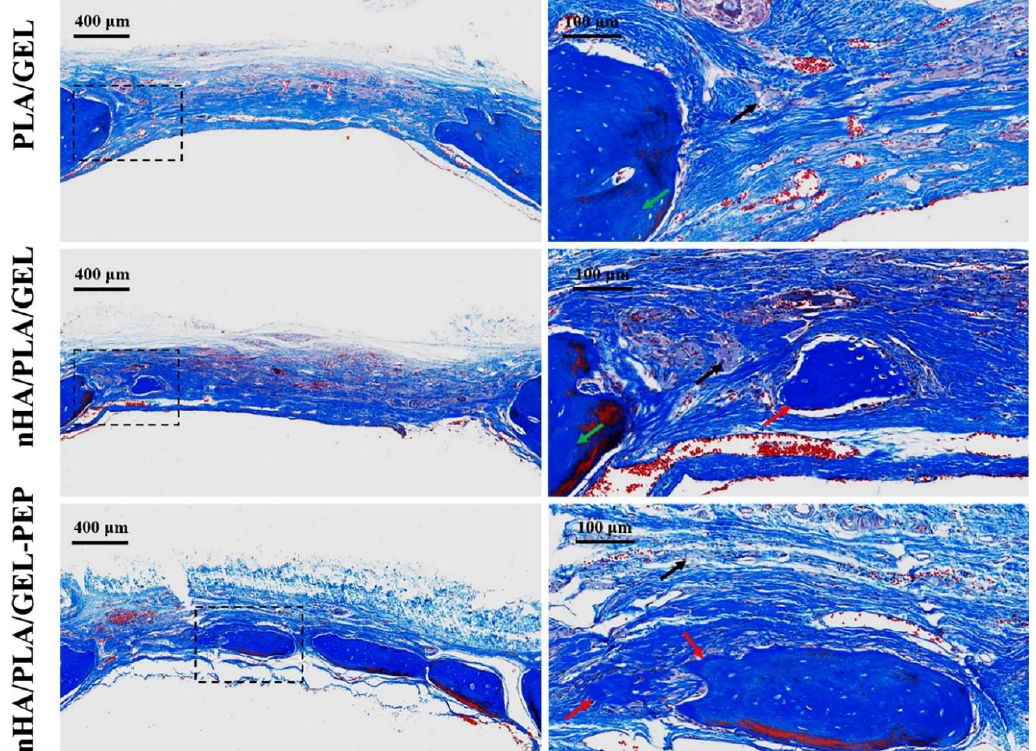
Figure 4. Masson’s trichrome-stained images of the newly formed bone within the repaired tissue eight weeks after surgery, using scaffolds made of PLA/gelatin (GEL), nano-hydroxyapatite (nHA)/PLA/GEL and nHA/PLA/GEL/BMP-2 peptide (-PEP). Red arrows indicate new bone, green arrows indicate host bone and black arrows indicate residual scaffolds. Residual scaffolds were all clearly filled with intercellular collagen fibers stained blue, and the newly formed bone tissue was dark blue because of the existence of abundant and compact collagen. New bone regenerated in the nHA/PLA/GEL-PEP group existed both in the middle and limbic of the defects (used with permission from [171]).